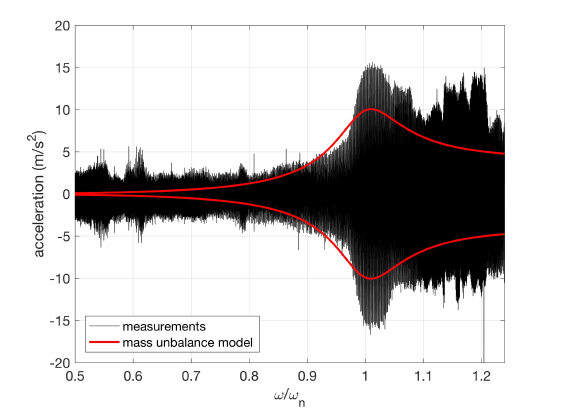
Figure 15. Comparison of measured acceleration on tower in Y direction against the amplitude of acceleration predicted by the mass unbalance